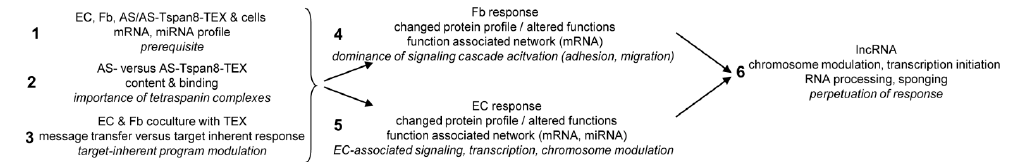
Figure 1. Experimental workflow.